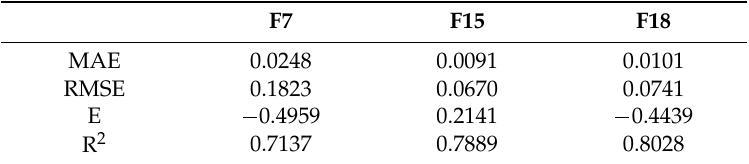
Table 3. Summary of calibration errors in the transient simulation (MAE: Mean Absolute Error; RMSE: Root Mean Square Error; E: Nash-Sutcliffe coefficient and R 2 : Correlation Coefficient).